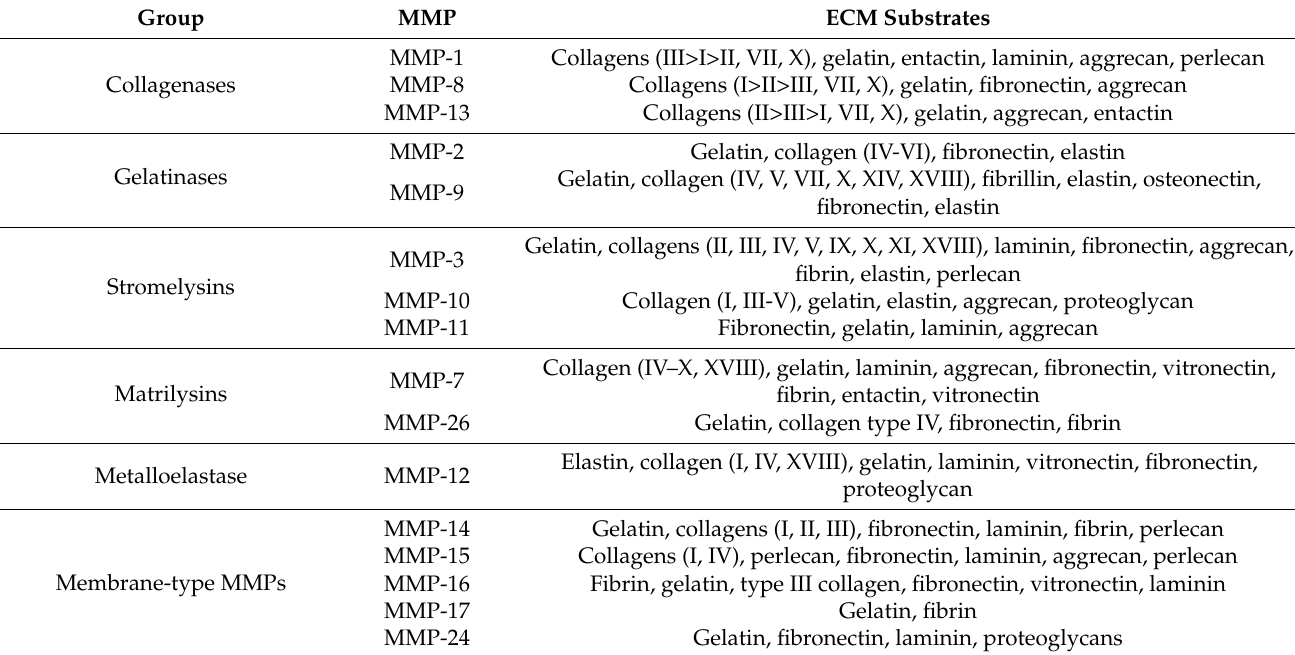
Table 1. Classification of major MMPs and their substrate specificity for ECM